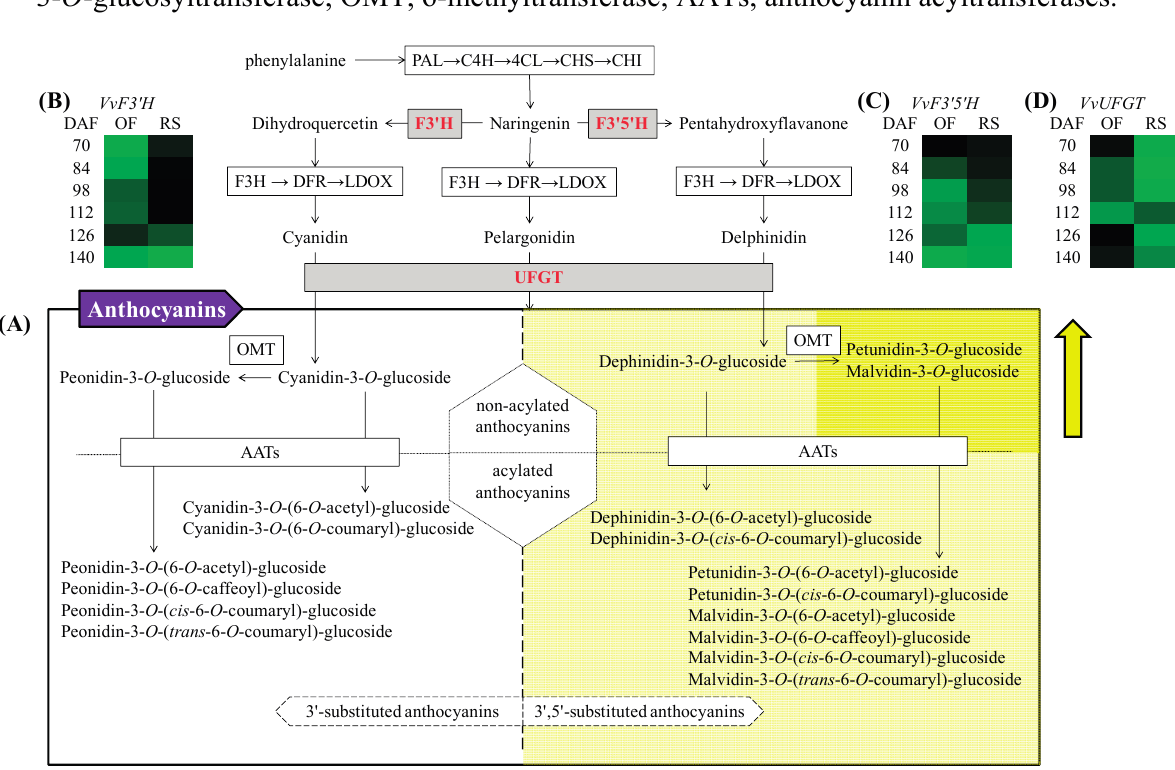
Figure 1. Biosynthetic pathway of anthocyanidins in grape (based on [12], only detected anthocyanins are listed in this figure, ( A )).The relative expression amount of VvF3'H ( B ), VvF3'5'H ( C ) and VvUFGT ( D ) is shown using three heat maps. Green squares from dark to bright represent the gene expression levels from high to low during the mature period (DAF70 to 140) with respect to both open-field cultivation (OF) and rain-shelter cultivation (RS). The yellow square shown in the anthocyanins block indicates that the compounds from this branch have higher concentration in berry skins under rain-shelter cultivation in comparison to open-field at commercial harvest. Abbreviations: DAF, days after flowering; PAL, phenylalanine ammonia-lyase; C4H, cinnamate 4-hydroxylase; 4CL, 4-coumarate: CoA ligase; CHS, chalcone synthase; CHI, chalcone isomerase; F3'H, flavonoid 3'-hydroxylase; F3'5'H, flavonoid 3',5'-hydroxylase; F3H, flavanone 3-hydroxylase; DFR, dihydroflavonol reductase; LDOX, leucoanthocyanidin dioxygenase; UFGT, UDP-glucose: flavonoid 3- O -glucosyltransferase; OMT, o-methyltransferase; AATs, anthocyanin